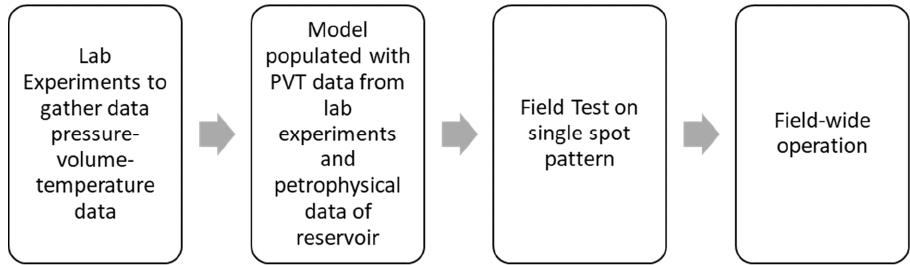
Figure 10. Complete workflow from lab experiments to field wide operation of in-situ combustion, this workflow allows for the best results in ISC operation.